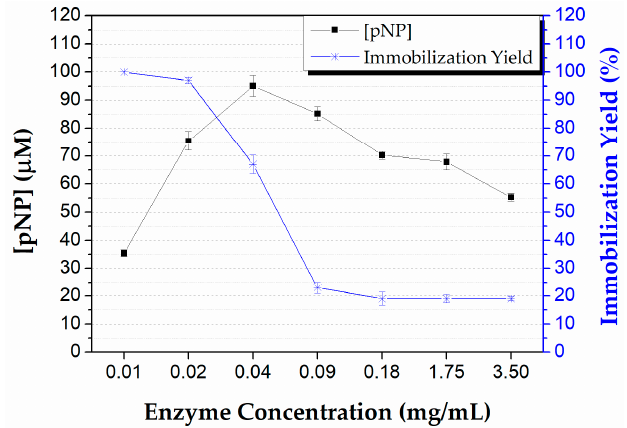
Figure 7. Effect of enzyme concentration on the microreactor’s biocatalytic performance and immobilization yield. Reaction conditions: 0.25 mM pNPB in 50 mM phosphate buffer pH 7.5, 40 °C, flow rate 300 μ L/min ( t R = 30 sec).